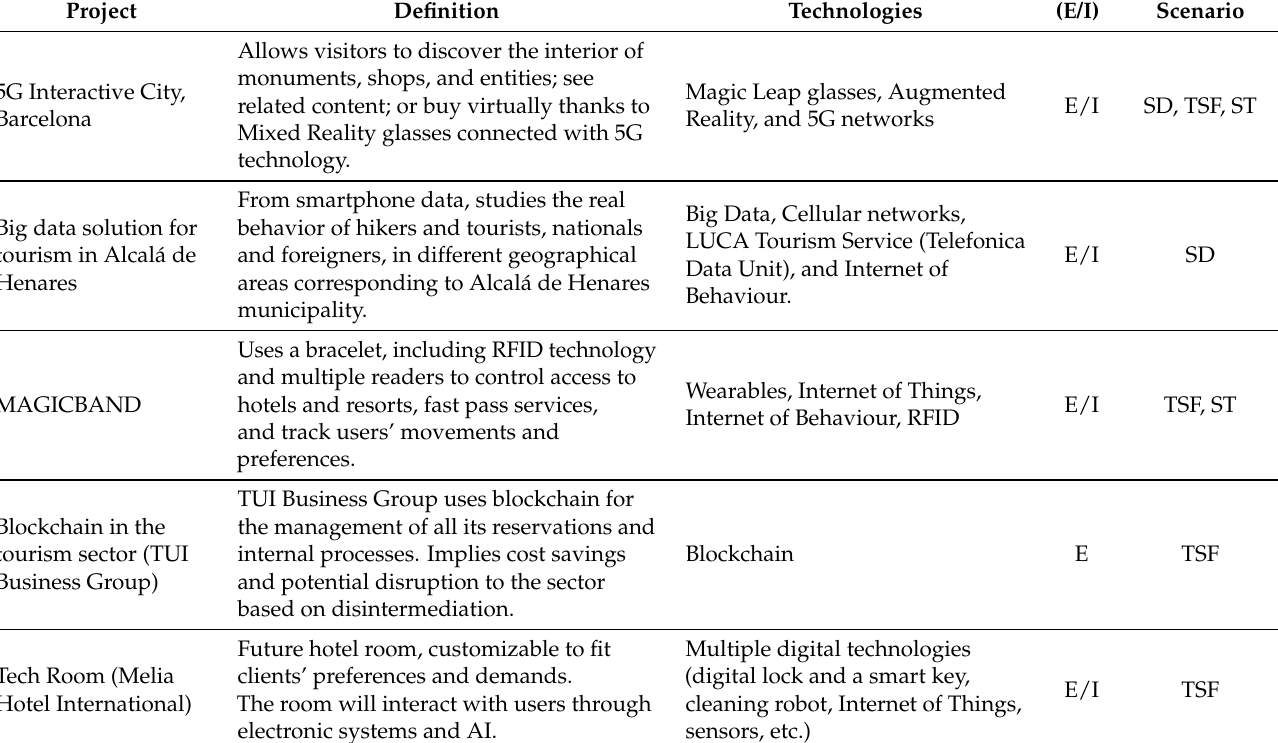
Table 1. Some significant initiatives in the use of ICT for Tourist